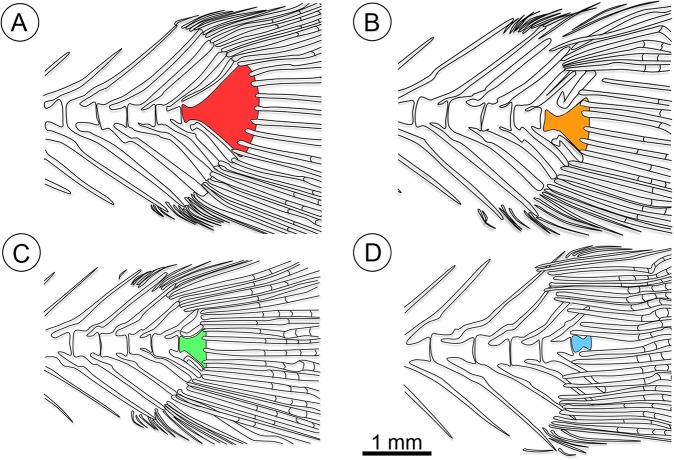
Reconstructions of the caudal skeletons of four specimens of †K. kipkechi sp. nov. showing the polymorphism in the hypural plate dimensions.
A, paratype 1237R(1)´04; B, paratype 1206(1)´04; C, paratype 1168´04; D, paratype 1146´04 (mirrored).